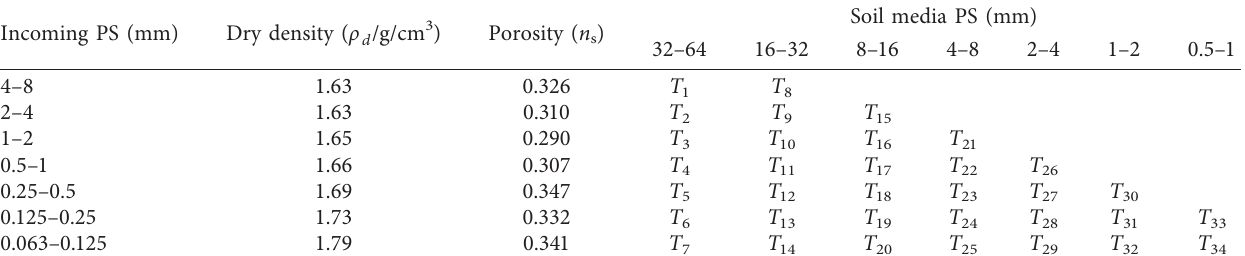
Table 1: Basic properties of soil media and corresponding PSs of incoming sediment.